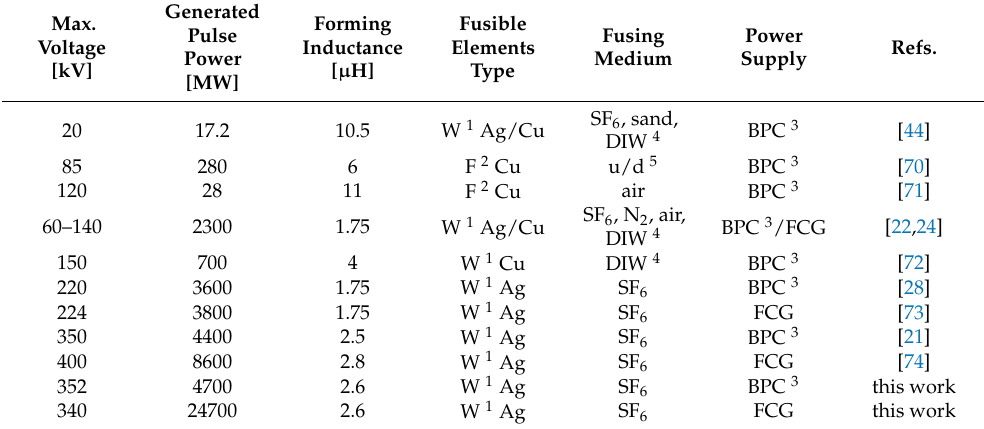
Table 3. FF-based pulse generation and forming systems parameters—literature overview. Max.